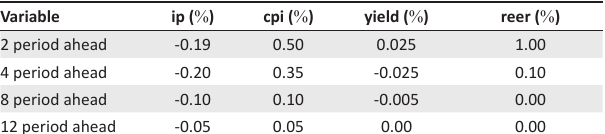
TABLE 2: Elasticity of selected macroeconomic variables following a 1 % positive economic policy uncertainty shock.